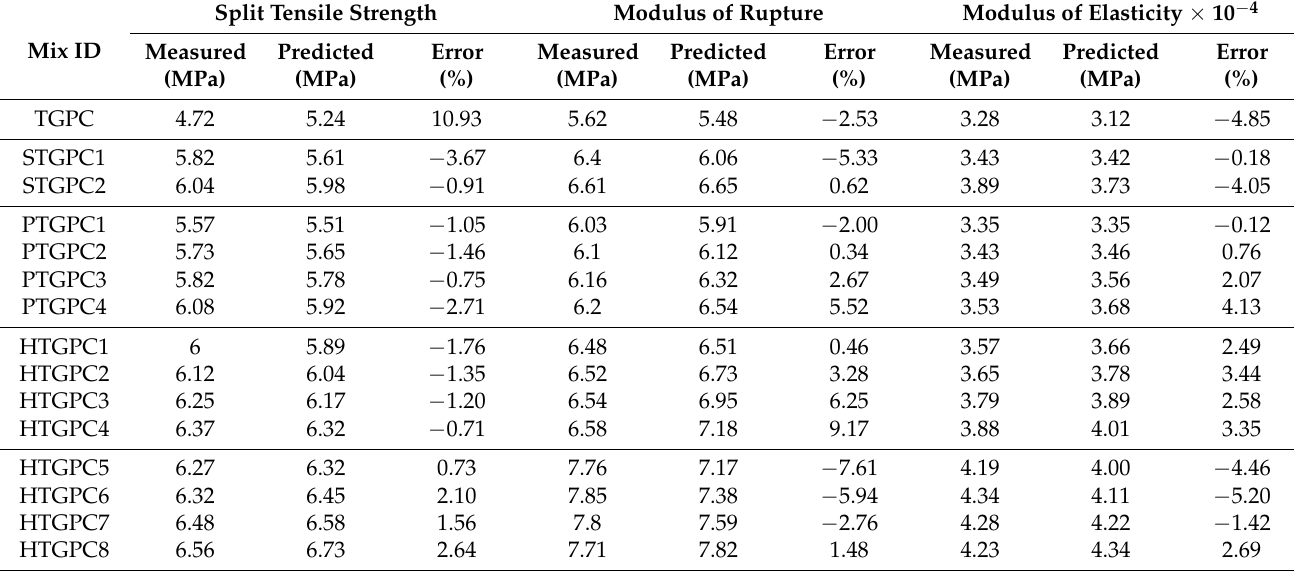
Figure 6. Relationship between f ct and F f √ f c . Table 8. Comparison of measured and predicted values.